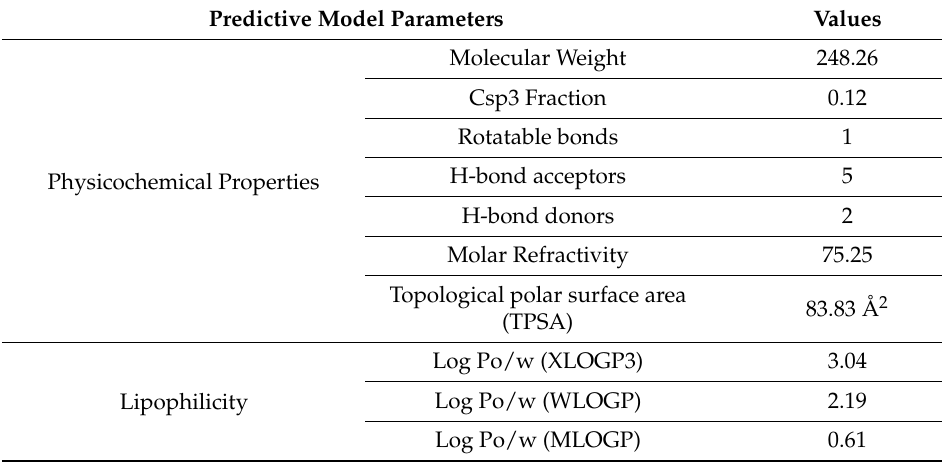
Table 12. ADME-related physicochemical parameters of